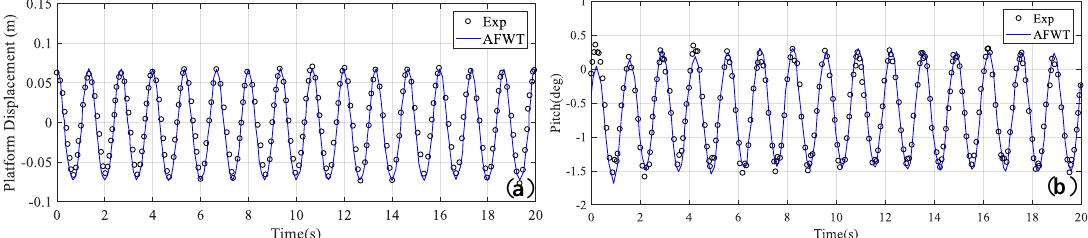
Figure 7. Comparison of the surge and pitch responses between the experiment and AFWT under a regular wave: ( a ) surge response; and ( b ) pitch response.